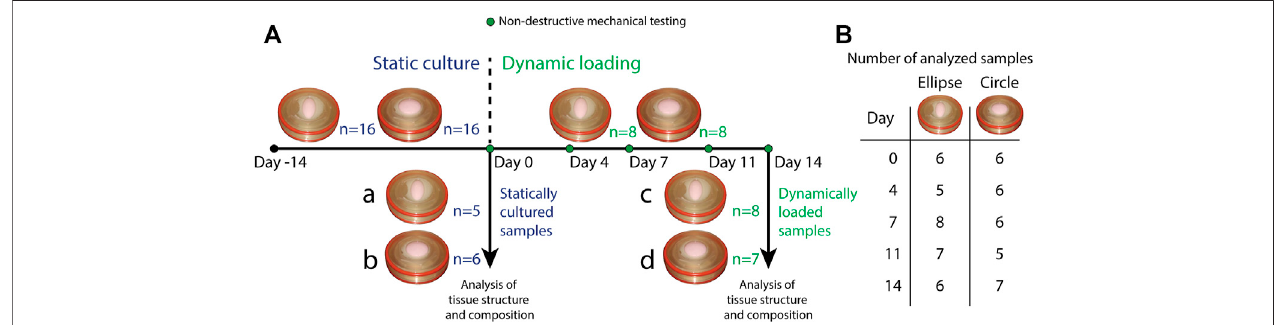
FIGURE 2 | (A) Overview of the experimental design. All samples ( n = 16 for both geometries) underwent static culture for 14 days. During static culture, three elliptical and two circular constructs detached from the insert and were therefore omitted from the analyses. After static culture, fi ve elliptical and six circular statically cultured constructs were sacri fi ced for analysis of structure and composition (a. statically cultured elliptical constructs, b. statically cultured circular constructs). The remaining eight constructs per geometry were dynamically loaded for 14 days. During these 14 days, constructs were mechanically characterized on day 0, 4, 7, 11, and 14. During dynamic loading, one circular construct detached from the insert and was omitted as well. After dynamic loading, the remaining samples (8 elliptical and seven circular constructs) were also sacri fi ced for analysis of structure and composition (c. dynamically loaded elliptical constructs, d. dynamically loaded circular constructs). (B) Overview of the number of mechanically characterized samples per construct geometry during dynamic loading. Numbers vary per day because during some measurements, pressure data was found to be improperly calibrated. These samples were therefore omitted from the analysis of that particular time